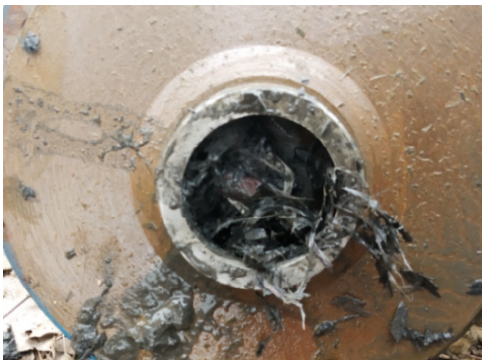
Figure 10. Blockage of the pump.